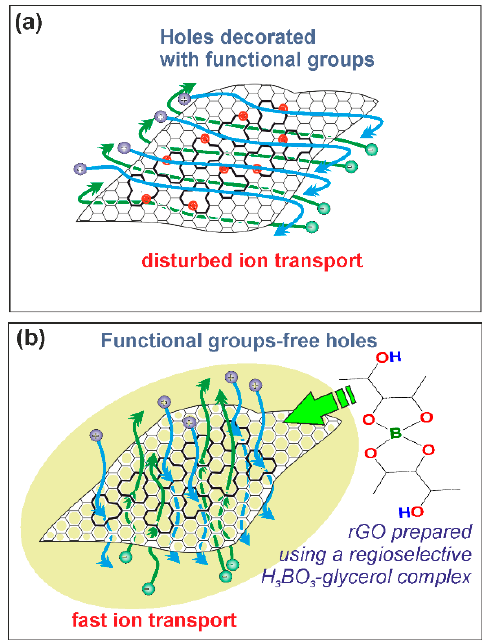
Figure 7. Formation of rGO structure without the presence of BA-glycerol catalyst ( a ) and in the presence of BA-glycerol catalyst ( b ). BA-glycerol catalyst prevents the formation of functional groups at the vacancy sites and facilitates the fast ion transport in electrode material.